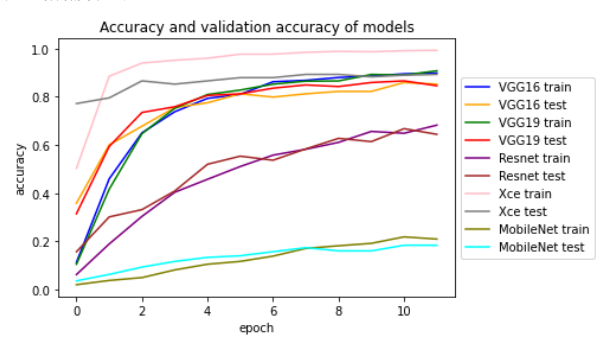
FIGURE VIII. ACCURACY AND VALIDATION ACCURACY OF MODELS DATASET 2 Figure VIII represent how accuracy (train) and validation